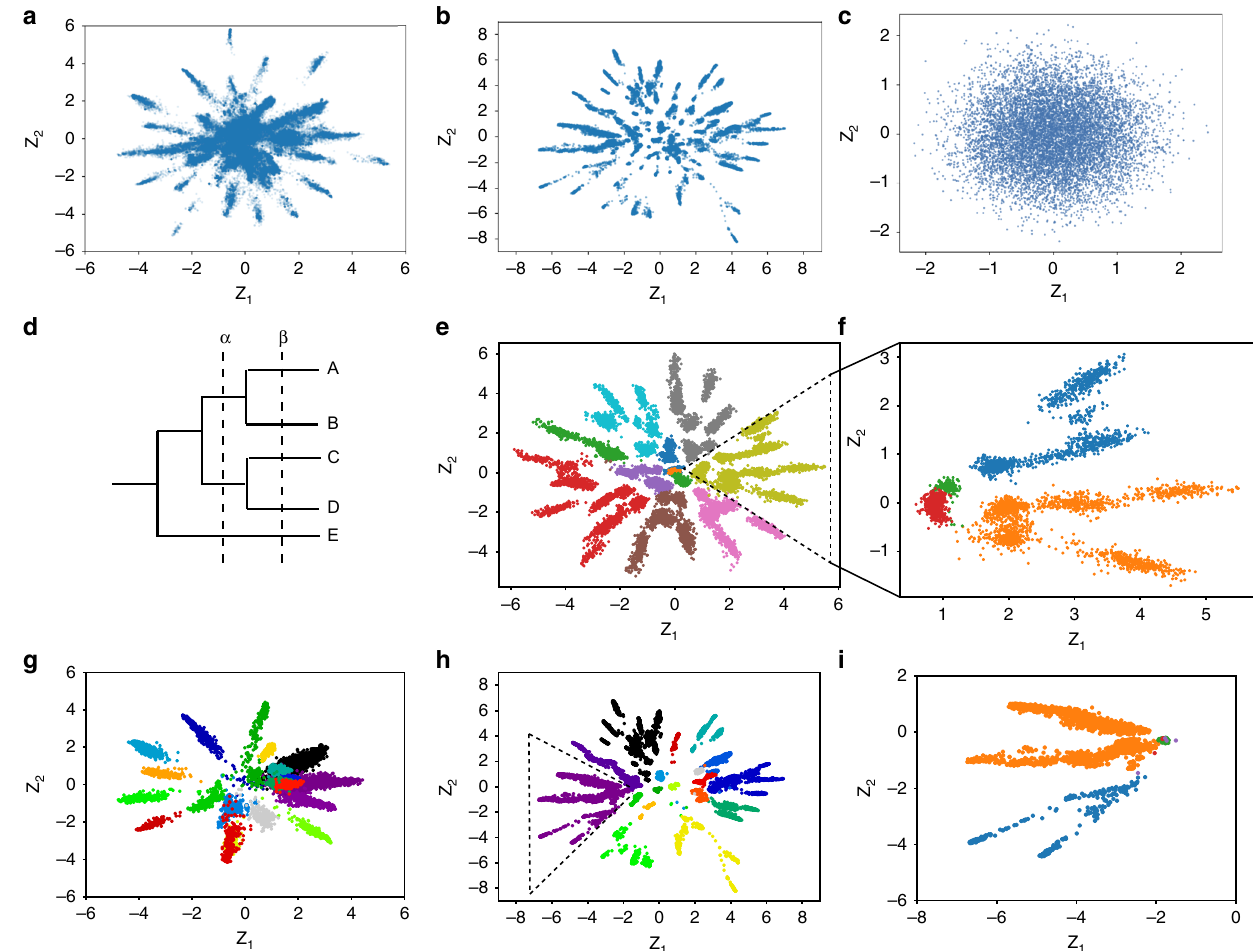
Fig. 2 Latent space representation of sequences captures phylogenetic relationships between sequences. a , b Latent space representation of sequences from the multiple sequence alignment of the fi bronectin type III domain and the cytochrome P450 family, respectively. c Latent space representation of 10,000 random sequences with 100 amino acids sampled from the equilibrium distributions of the LG evolutionary model. d A schematic representation of the phylogenetic tree used to simulate the evolution of a random protein sequence with 100 amino acids. The actual tree has 10,000 leaf nodes. The dashed lines, α and β , represent two reference evolutionary time points on which sequences of leaf nodes are grouped. Sequences of leaf nodes are in the same group if they are in the same branch at the reference time point, either α or β , which have an evolutionary distance of 0.5 and 0.9 from the root node, respectively. The evolutionary distance from the root node represents the expected number of substitutions per site compared to the root node sequence. e Latent space representation of simulated sequences of all leaf nodes. Sequences are separated into groups at the reference time point α . Sequences are colored based on groups. Quanti fi cation of the clustering can be found in Supplementary Fig. 4. f Sequences from the yellow colored group (enclosed by the dashed triangle) in e are regrouped and recolored based on the reference time point β . g Latent space representation of grouped sequences of the fi bronectin type III domain family. A phylogenetic tree is inferred based on its MSA using FastTree2. Based on the inferred phylogenetic tree, sequences are grouped similarly as in d , e with an evolutionary distance of 2.4. The top 20 largest groups of sequences are plotted and sequences are colored based on their group. h A similar plot as g for the cytochrome P450 family. i Sequences from the purple colored group (enclosed by the dashed triangle) in h are regrouped and recolored based on a reference time point with an evolutionary distance of